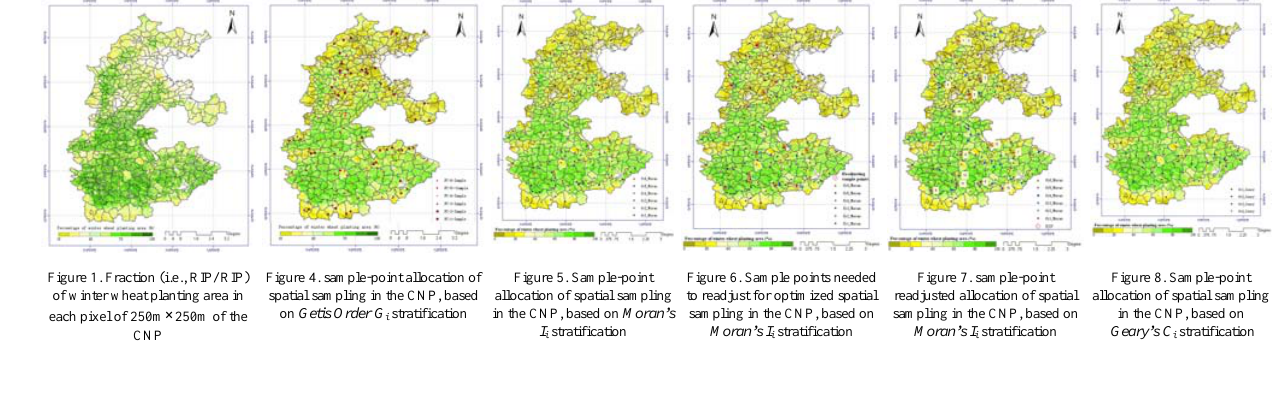
Figure 5. Sample-point Figure 6. Sample points needed allocation of spatial sampling to readjust for optimized spatial in the CNP, based on Moran’s sampling in the CNP, based on I i stratification Moran’s I i stratification